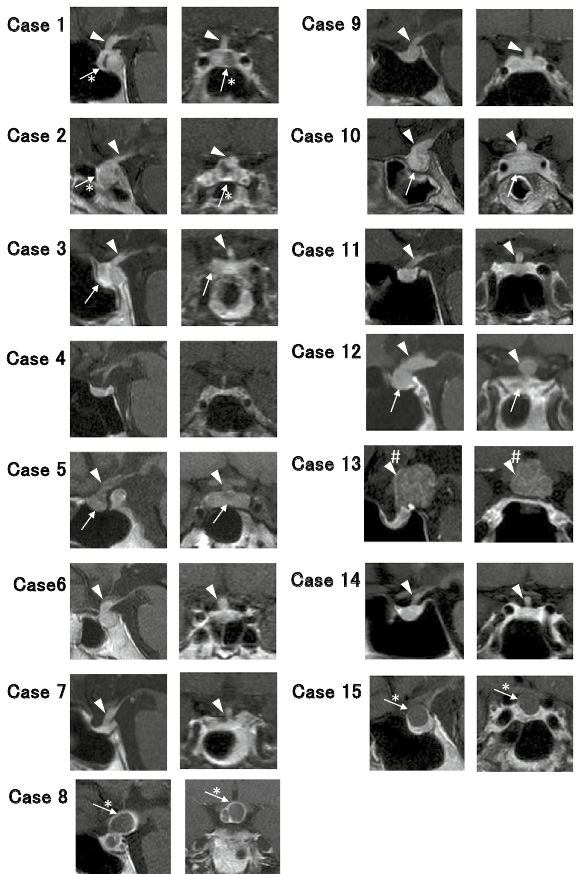
Figure 1. T1-weighted MR images of the pituitary in the 15 patients. The images from Case 5 were not enhanced because the patient was pregnant. All other images were enhanced by gadolinium contrast medium. Sagittal (left) and the coronal (right) sections from each patient are shown. Arrowheads indicate thickened pituitary stalks, and arrows indicate enlarged pituitary glands. *Indicates a cystic component, and #Indicates a well-defined tumor.